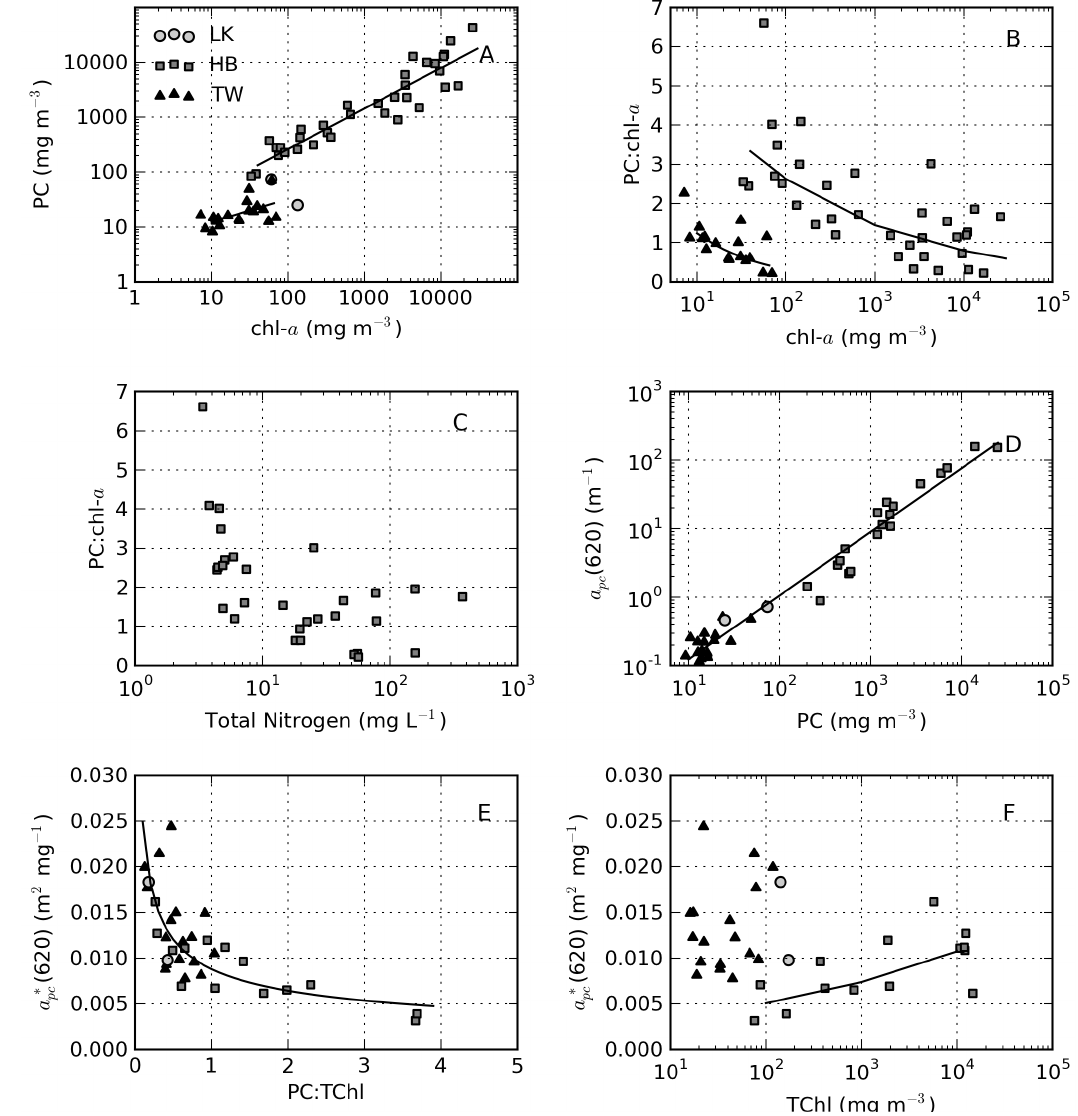
Figure 17. ( A ) chl- a versus PC showing the best fit lines for HB and TW; ( B ) The PC:chl- a ratio versus chl- a showing best fit lines for HB and TW; (C) The PC:chl- a ratio versus total nitrogen concentration; ( D ) a (620) versus PC showing the power-law best fit line; ( E ) the pc (620) showing the power-law best fit (620); ( F ) TChl- a versus a ∗ PC:chl- a ratio versus a ∗ pc pc line for HB. The legend is the same in all plots. Note the log